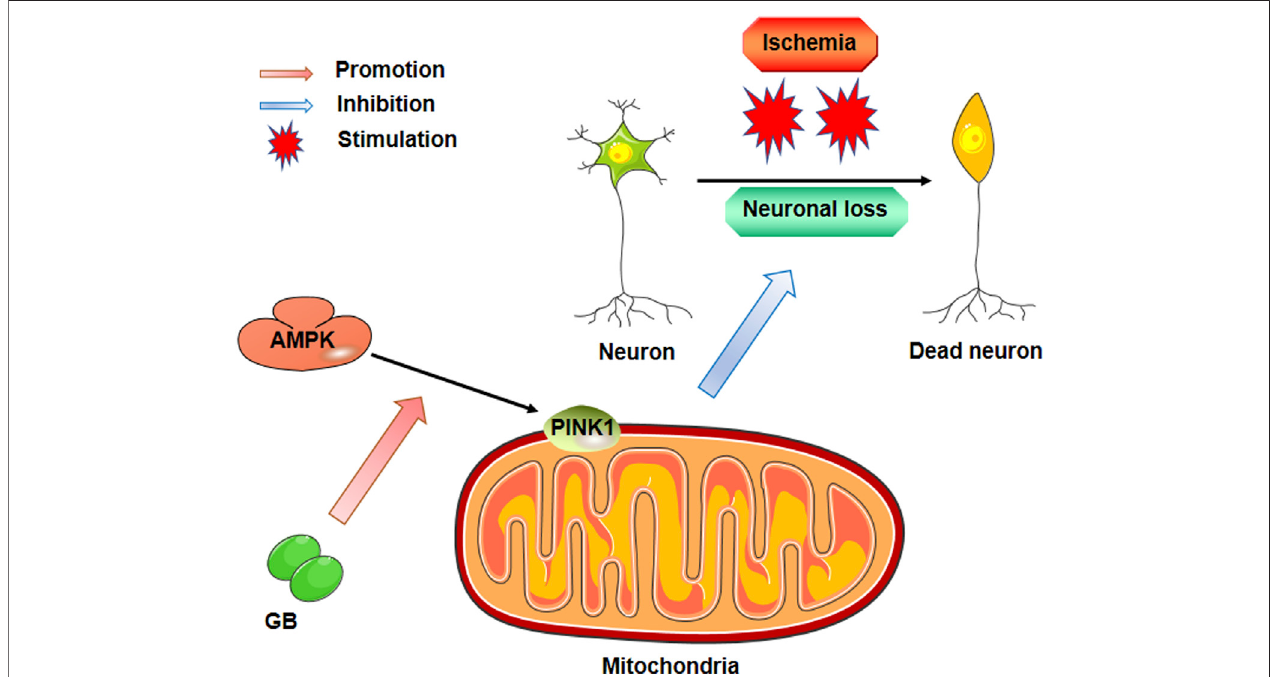
FIGURE 5 | Pharmacological mechanism of Ginkgolide B against neuronal loss post ischemic stroke.